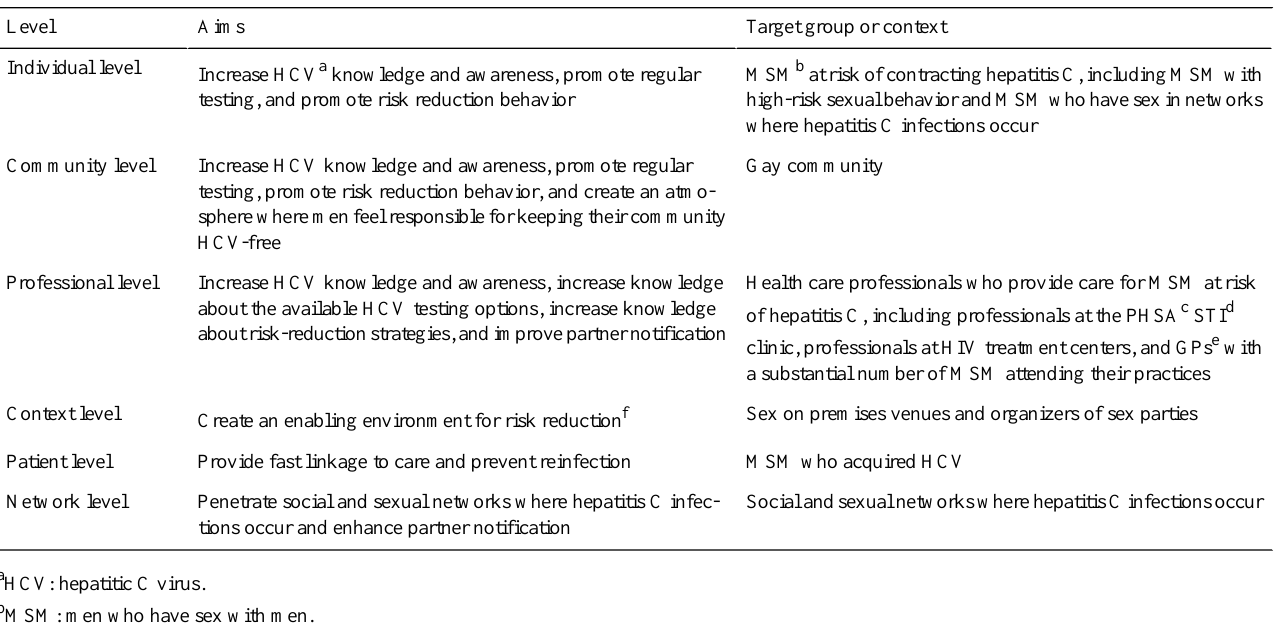
Table 1. Levels and corresponding project aims and target groups of the NoMoreC project.